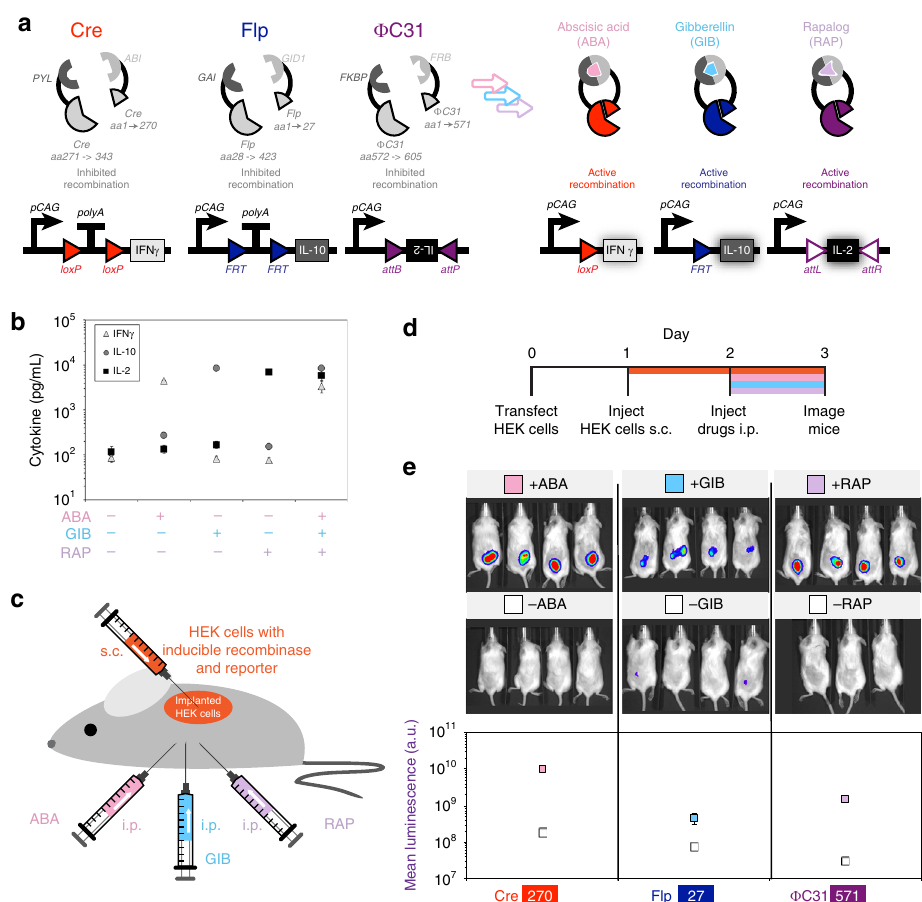
Fig. 5 Applications of split recombinases. a A genetic switchboard using three inducible split recombinases to individually control expression of three therapeutically relevant human cytokines, interferon- γ (IFN γ ), interleukin-2 (IL-2), and interleukin-10 (IL-10). Drugs were added 1 day post transfection. b Measurement of supernatant cytokine concentration using enzyme-linked immunosorbent assays ( n = 3). c A xenograft mouse model of split recombinases used in a that were transfected in human embryonic kidney (HEK) cells alongside a corresponding luciferase reporter that expresses upon site-speci fi c recombination. Transfected cells are transplanted subcutaneously (s.c.) and drugs or vehicle-only control are injected intraperitoneally (i.p.). d Time-course depicting time of transfection, injections, and imaging. e Images and averaged values of emitted luminescence from three split-recombinase systems. Error bars of mean cytokine and luminescence values indicate the arithmetic standard error of the mean. Source data are provided as a Source Data fi